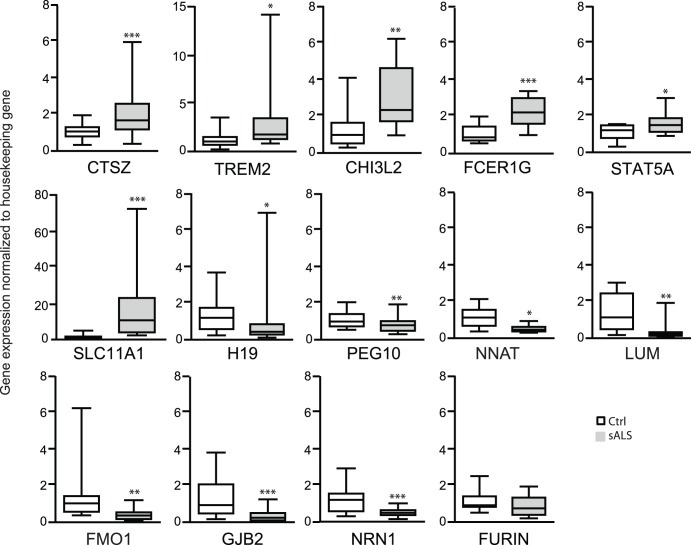
RT-PCR confirmation of concordant epigenes in spinal cord.RNA was extracted from the postmortem human spinal cord tissue that was used for the methylation analysis from sALS (n = 8–11) subjects and controls (n = 8–11) and subjected to RT-PCR. Results were normalized to glyceraldehyde-3- phosphate dehydrogenase (GAPDH) except for STAT5A which was normalized to TATA box binding protein (Tbp) and presented as fold changes calculated by the 2−ΔΔC
T method. Similar results were obtained when using different housekeeping genes (Fig. S2); *p<0.05, **p<0.01, ***p<0.001 compared to the control group (Ctrl). Data mean ± SEM is plotted using box and whiskers vertical bars plotting minimum to maximum values.